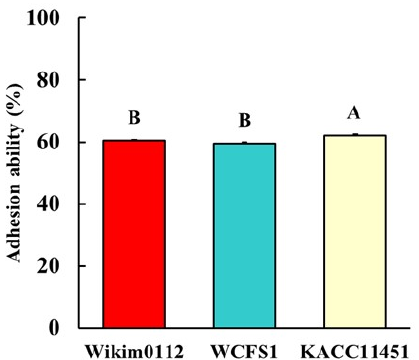
Figure 4. The adhesion ability of Lpb. plantarum Wikim0112, WCFS1, and KACC11451 in Caco-2 cells. The cells were exposed to Lpb. plantarum strain at 37 ◦ C for 2 h. The adhesion rates were calculated by counting the number of bacteria before and after incubation. The values represent the mean ± SEM (n = 4). Different letters represent significant difference ( p < 0.5).